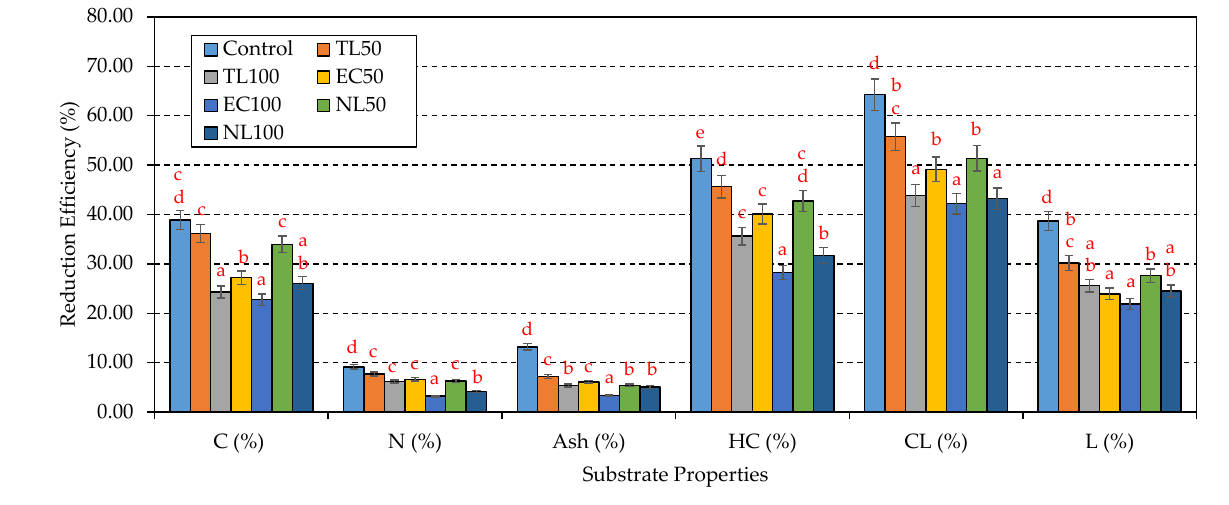
Figure 2. Reduction efficiency (%) of mushroom substrate properties before and after P. florida cultivation (The same letters (a–e) indicate no significant difference between treatment group values; TL: Typha latifolia ; EC: Eichhornia crassipes ; NL: Nelumbo nucifera ; EC: electrical conductivity; C: carbon; N: nitrogen; HCL: hemicellulose; CL: cellulose; L: